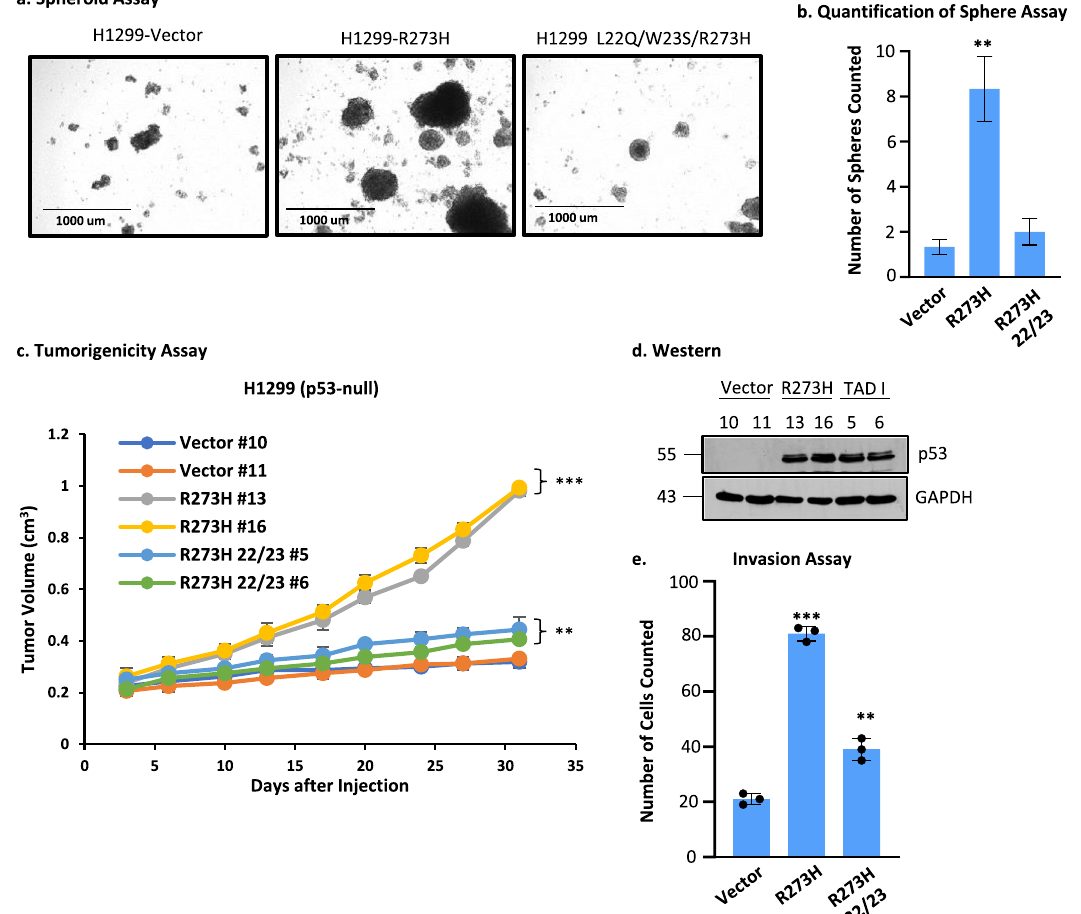
Fig. 2 Human p53-R273H TAD defects reduce oncogenicity of H1299 cells. a Spheroid growth assay with H1299 p53-null lung cancer cells expressing p53-R273H, -L22Q/W23S/R273H, or vector control. Representative images are shown from each cohort. b Quanti fi cation of spheroid assay. The number of colonies were counted across multiple fi elds and plotted as the mean ±SEM ( n = 3). A two-sided Student ’ s t -test was performed, ** p = 0.0093. The most colonies are formed in H1299 p53-R273H cells. c A tumorigenicity assay was performed using cells from the spheroids formed in a injected subcutaneously in the fl anks of NOD SCID mice. Data are presented as the mean ±SEM ( n = 4). A two-sided Student ’ s t -test was performed comparing the vector cell lines, ** p = 0.0369 and *** p = 0.00017. Vector control and L22Q/W23S/R273H grew much slower compared to R273H. d Western blot showing levels of p53 in cell clones. e Invasion assay performed using cells from the spheroids in a . Data are presented as the mean± SEM ( n = 3). A two-sided Student ’ s t -test was performed, ** p = 0.0022 and *** p = 6.18E – 6. Sphere formation, tumorigenicity, and invasion are all affected by mutation at